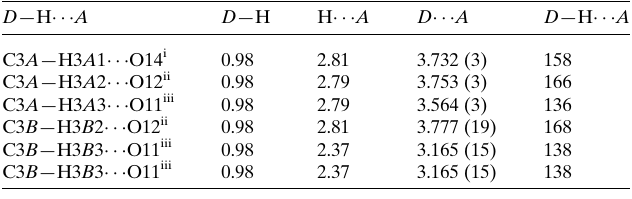
Table 2 Hydrogen-bond geometry (A˚ , (cid:4) ).